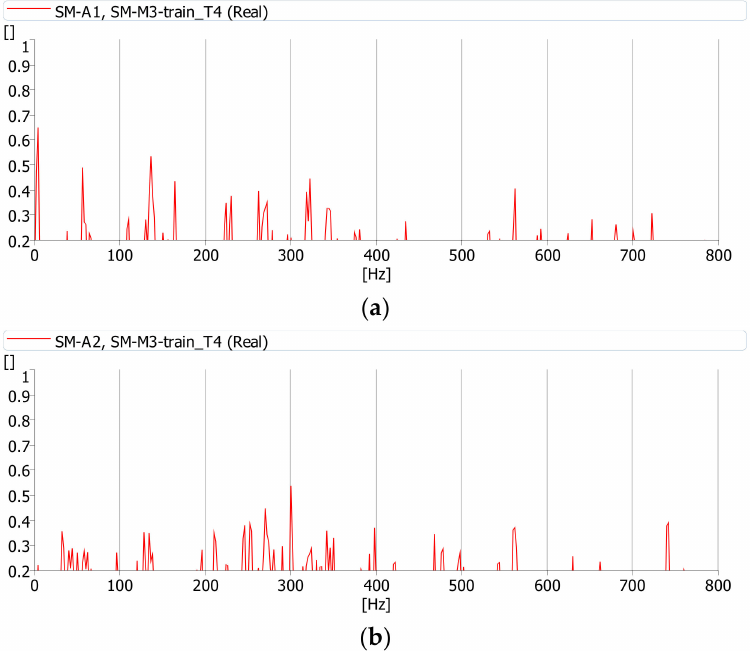
Figure 13. Coherence function between acoustic pressure at point M3 and: ( a ) vibrations at point A1 (deck slab), ( b ) vibrations at point A2 (girder web) during the passage of a passenger train (T4).